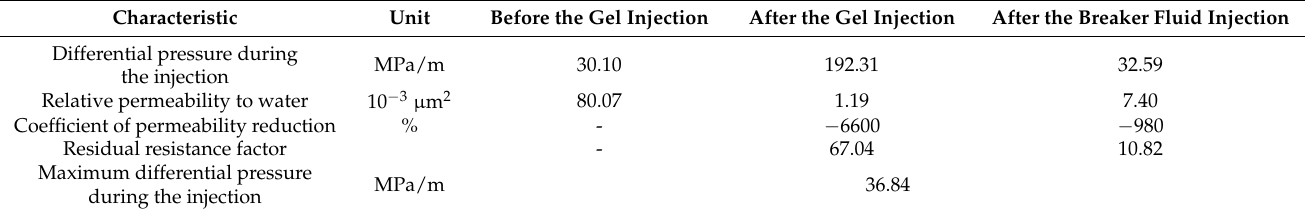
Table 4. Results of the flooding experiment on water-saturated fractured porous core